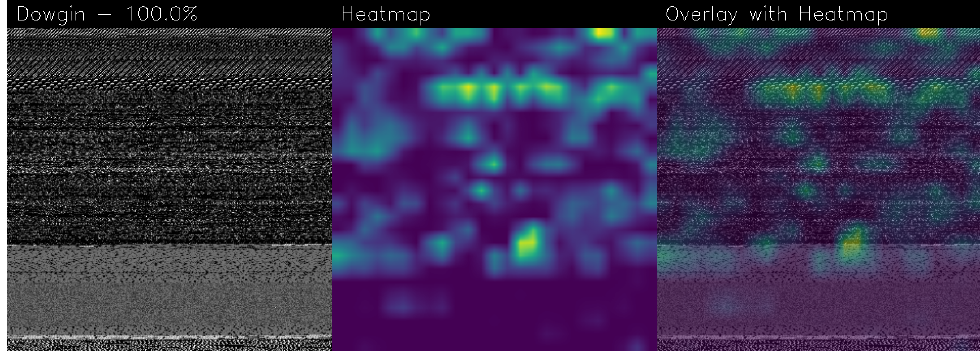
Figure 10. Sample classified as belonging to the Downgin family (0d1366528bf2276fdc686b1f3deb38e5) with 100%, where we can note the yellow